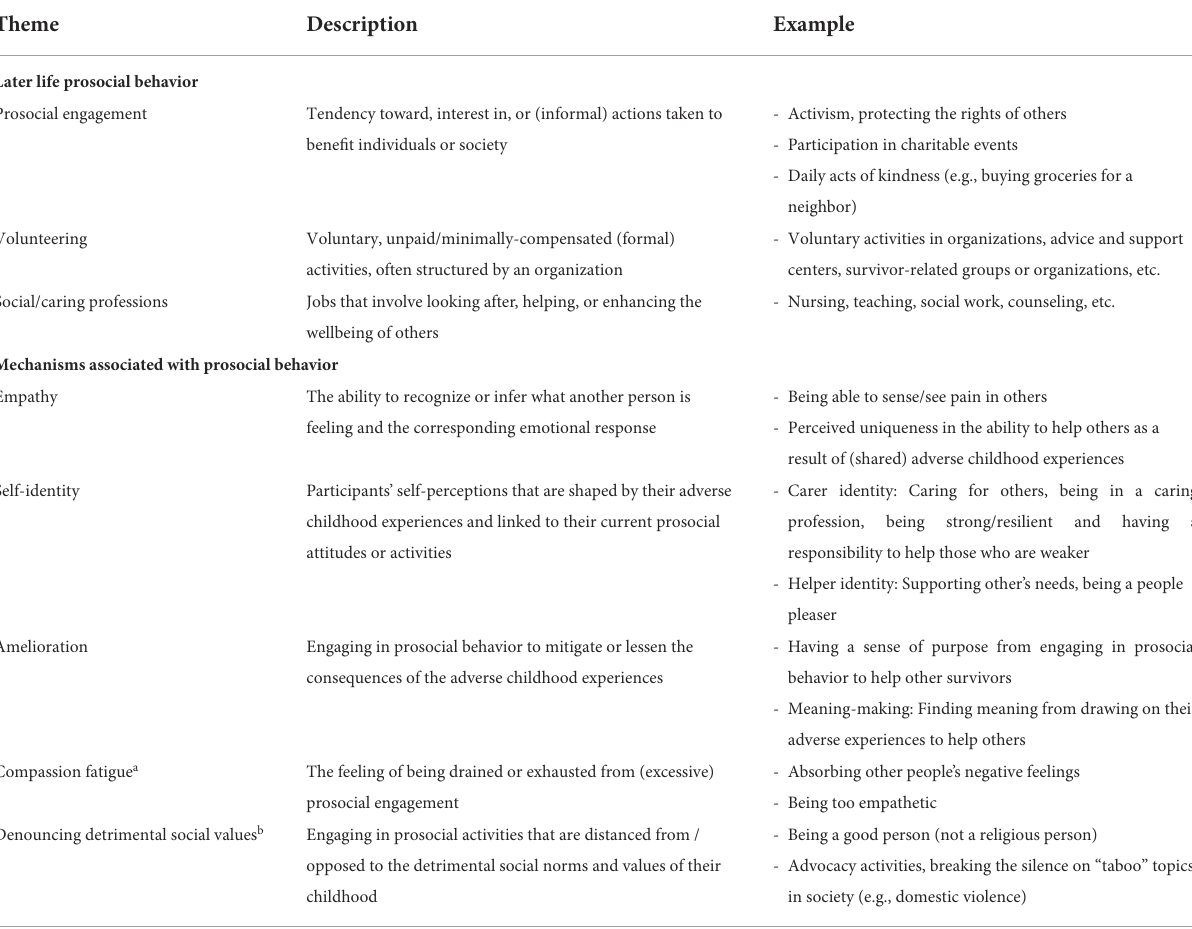
TABLE 3 Overview of themes—Mechanisms associated with later life prosocial behavior in survivors of adverse childhood